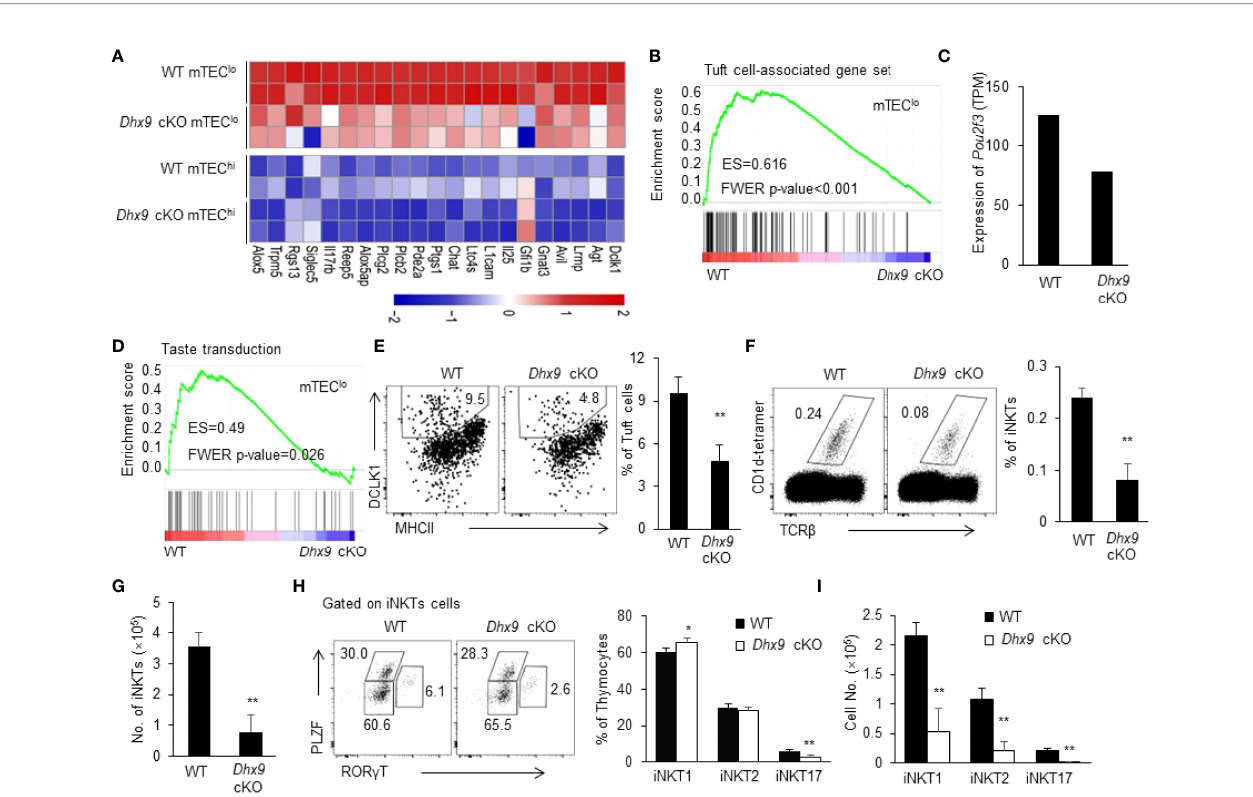
FIGURE 3 | Dhx9 de fi ciency in TECs severely affected the development of thymic tuft cells. (A) The heatmap showed the differentially expressed genes in the bulk RNA- seq data from 4-week-old WT and Dhx9 cKO mice that were highly expressed in thymic tuft cells. (B) The GSEA analysis of the Tuft cell-associated gene set between WT and Dhx9-de fi cient mTEC lo ; P < 0.05. (C) The expression of Pou2f3 in mTEC lo from 4-week-old WT and Dhx9 cKO mice from the bulk RNA-seq data. (D) GSEA showed the taste transduction pathway gene set enriched in Dhx9 cKO mTEC lo ; P < 0.05. (E) The representative fl ow cytometry plots (left) and percentage (right) of the thymic tuft cells were distinguished by the expression of MHCII and DCLK1 between 4-week-old WT and Dhx9 cKO mice ( n = 5 for each group). (F) Representative fl ow cytometry plots and percentages of iNKT cells in 4-week-old WT and Dhx9 cKO mice ( n = 5 for each group). (G) Cell number of iNKT cells in 4-week-old WT and Dhx9 cKO mice ( n = 5 for each group). (H) The distinct cell population of iNKT1, iNKT2, and iNKT17 between 4-week-old WT and Dhx9 cKO mice ( n = 5 for each group) were analyzed via fl ow cytometry. (I) Number of iNKT1, iNKT2, and iNKT17 in 4-week-old WT and Dhx9 cKO mice ( n = 5 for each group). One representative histogram represented the mean ± SD. The unpaired, two-tailed student ’ s t -test was used. * P < 0.05, ** P < 0.01 compared with WT control